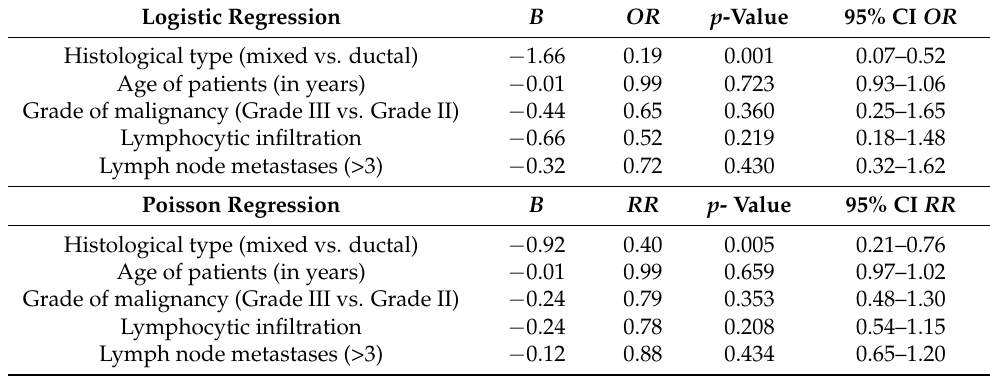
Table 5. Multiple logistic and Poisson regression models with five-year survival as the outcome variable. Logistic Regression B OR p -Value 95% CI OR Histological type (mixed vs. ductal) − 1.66 0.19 0.001 0.07–0.52 Age of patients (in years) − 0.01 0.99 0.723 0.93–1.06 Grade of malignancy (Grade III vs. Grade II) − 0.44 0.65 0.360 0.25–1.65 Lymphocytic infiltration − 0.66 0.52 0.219 0.18–1.48 Lymph node metastases (>3) − 0.32 0.72 0.430 0.32–1.62 Poisson Regression B RR p - Value 95% CI RR Histological type (mixed vs. ductal) − 0.92 0.40 0.005 0.21–0.76 Age of patients (in years) − 0.01 0.99 0.659 0.97–1.02 Grade of malignancy (Grade III vs. Grade II) − 0.24 0.79 0.353 0.48–1.30 Lymphocytic infiltration − 0.24 0.78 0.208 Lymph node metastases